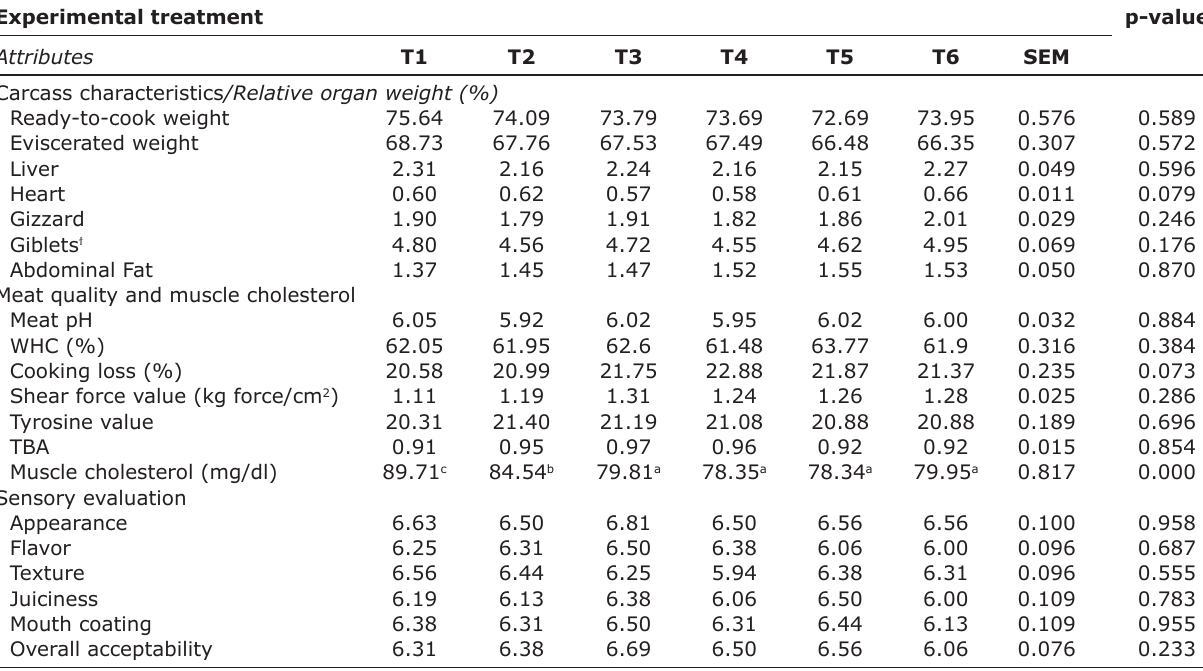
Table-2: Effect of supplementation of cinnamon oil and coated sodium butyrate on carcass characteristics (percent), meat quality and muscle cholesterol, and sensory evaluation in broilers. Experimental